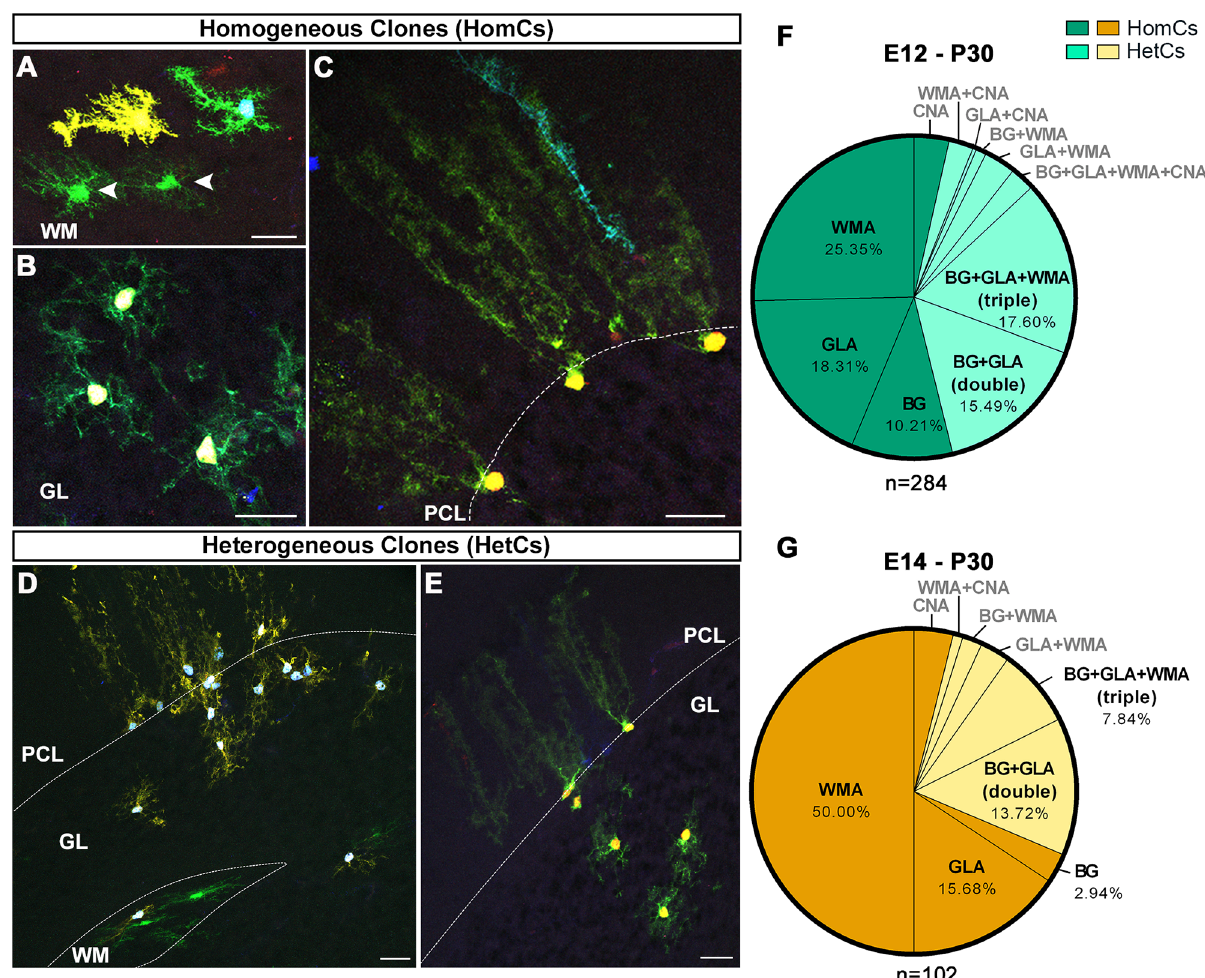
Fig 2. Composition of clones derived from E12 or E14 progenitors. (A-C) HomCs composed of WMAs (A; arrowheads indicate sister cells), GLAs (B), or BG (C) are generated by both early- and late-tagged progenitors. (D,E) The 2 major types of HetCs include triple clones made of BG+GLA +WMA (D) and double clones made of BG+GLA (E). (F,G) HomCs (dark shade) and HetCs (light shade) are produced in different frequencies by E12 (F) and E14 progenitors (G, P = 0.009). Among HetCs, BG+GLA+WMA clones are more numerous in E12-P30 compared to E14-P30 clones ( P = 0.023), whereas BG+GLA clones do not vary ( P = 0.748). Whereas WMA HomCs double in frequency in E14-P30 clones compared to E12-P30 clones ( P < 0.001), BG HomCs decrease significantly ( P = 0.021). Pies illustrate pooled data from 3–4 animals. (F) Minor fractions: CNA = 3.52%, WMA+CNA = 2.47%, GLA+CNA = 0.35%, BG+WMA = 1.06%, WMA+GLA = 3.17%, BG+GLA+ WMA+CNA = 2.47%. (G) Minor fractions: CNA = 3.92%, WMA+CNA = 0.98%, BG+WMA = 1.96%, WMA+GLA = 2.94%. P values are calculated with Fisher’s exact test. n = number of clones. Green = E12-P30 clones; orange = E14-P30 clones. Scale bars: 30 μm. BG, Bergmann glia; CNA, cerebellar nuclei astrocyte; E, embryonic day; GL, granular layer; GLA, granular layer astrocyte; HetC, heterogeneous clone; HomC, homogeneous clone; P, postnatal day; PCL, Purkinje cell layer; WM, white matter; WMA, white matter